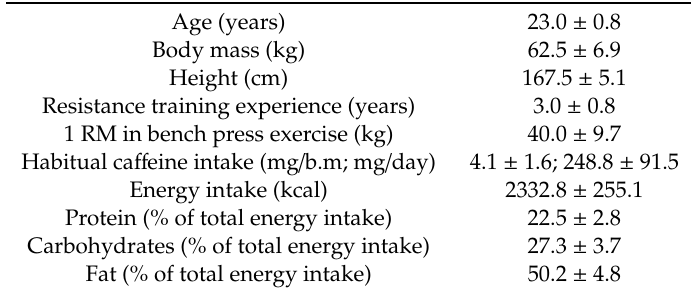
Table 1. Participants’